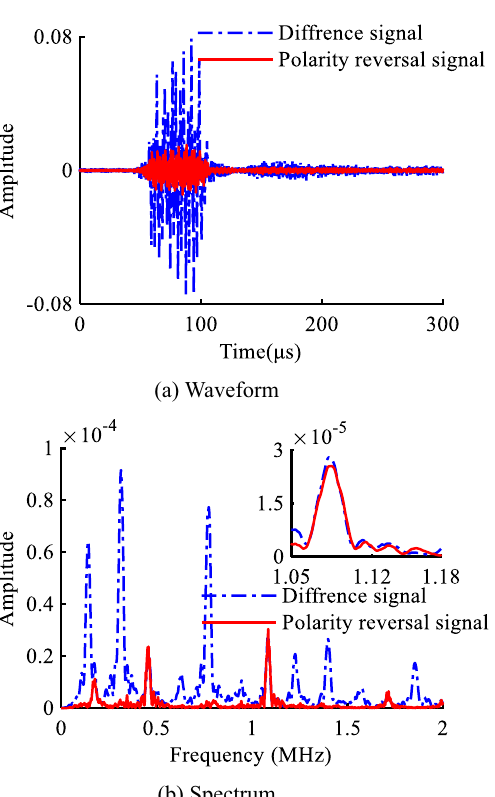
Figure 14 Typical signals obtained from collinear Lamb wave mixing experiments Figure 15 Comparison of nonlinear component